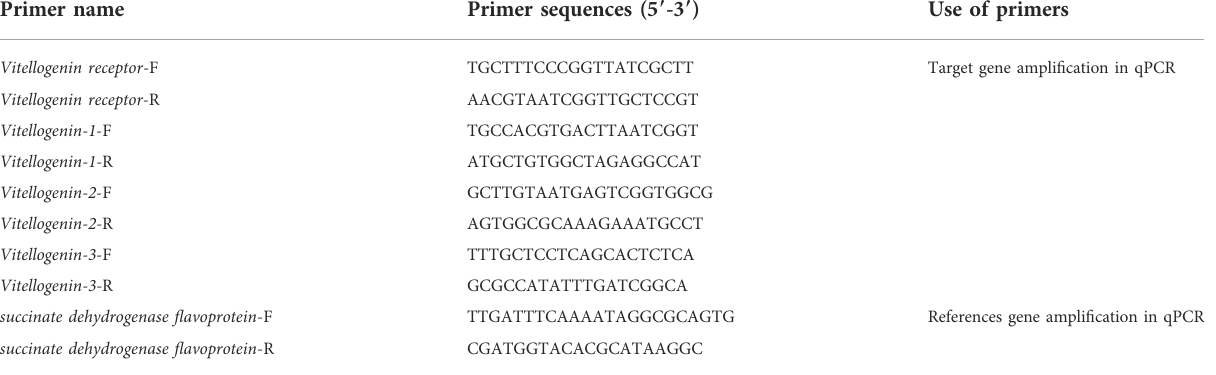
TABLE 1 Primer sequence information of target gene and reference